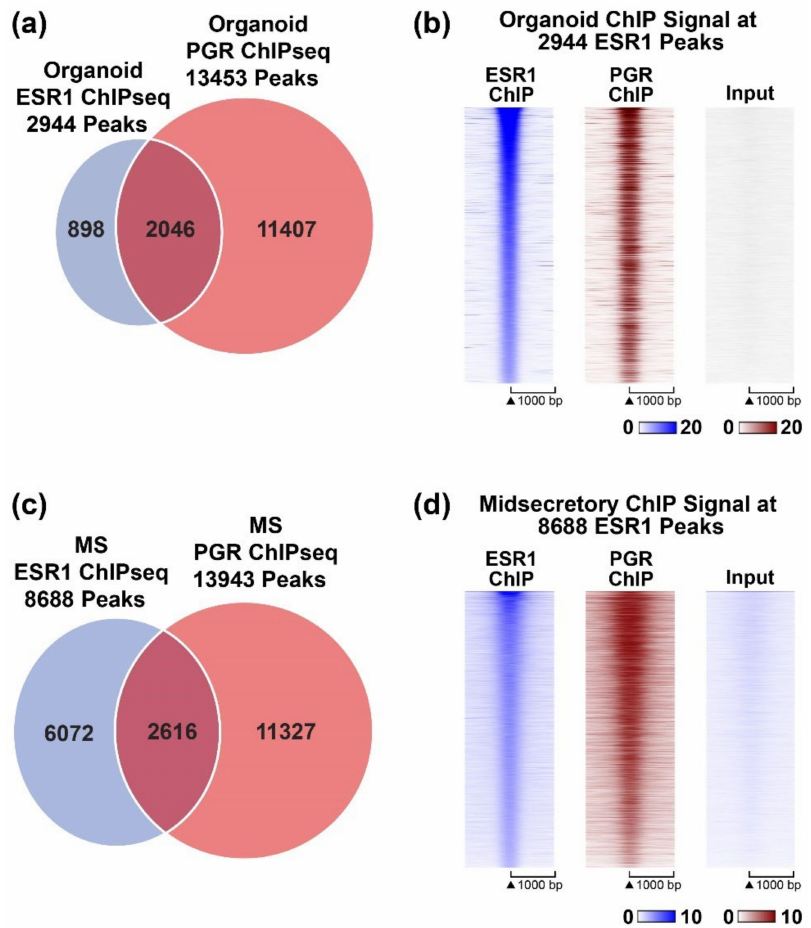
Figure 3. PGR and ESR1 ChIP peaks in organoids and in mid-secretory endometrium. ( a ) Comparison of locations of ESR1 and PGR peaks from organoids; ( b ) Heatmap indicating organoid ESR1 or PGR ChIP signal centered on ESR1 peak locations ( ± 1 kb) in organoids. ( c ) Comparison of locations of ESR1 and PGR peaks from mid-secretory endometrium ( d ) Heatmap indicating mid-secretory endometrium ESR1 or PGR ChIP signal centered on ESR1 peak locations ( ± 1 kb) in mid-secretory